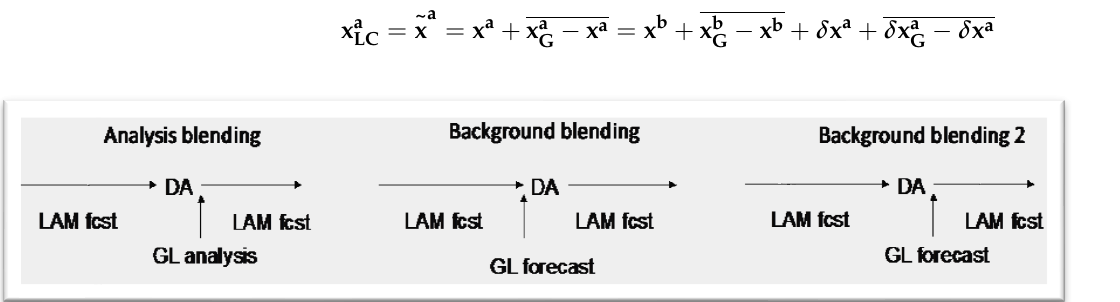
Figure 1. Schematic showing different blending approaches. From left: Analysis blending corrects the large-scale information in the LAM analysis using global (GL) analysis; background blending corrects the large-scale information in the LAM background using global forecast (fcst), which is then used in the LAM data assimilation (DA); background blending 2 corrects the large-scale information in the LAM background as in background blending but after DA.